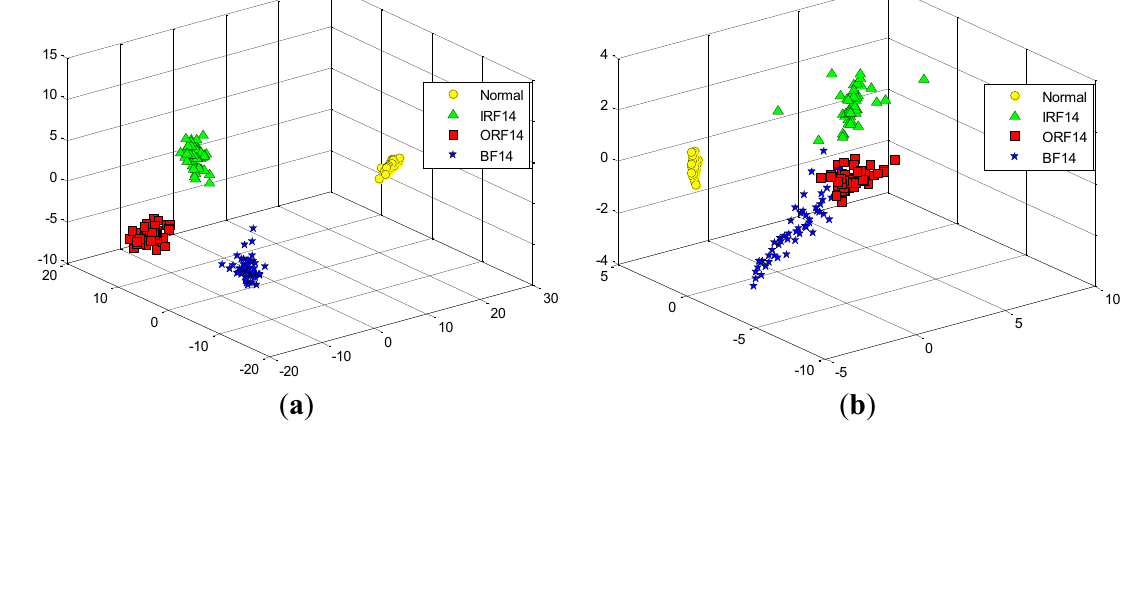
Figure 14. The data projection result with the first three eigenvectors in the D_MIX dataset using: ( a ) SR. ( b ) PCA. ( c ) FA. ( d )